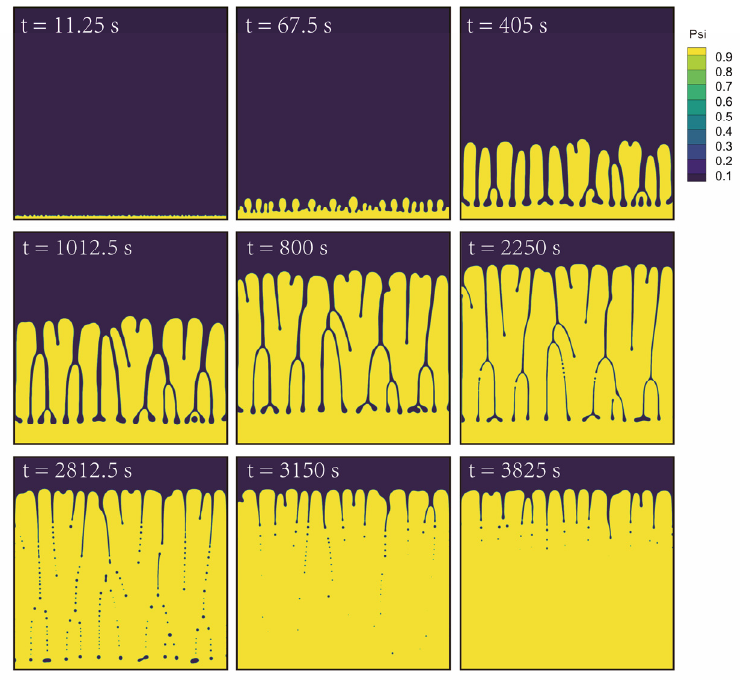
Figure 3. Microstructure growth simulation of bismuth telluride-based crystal material.